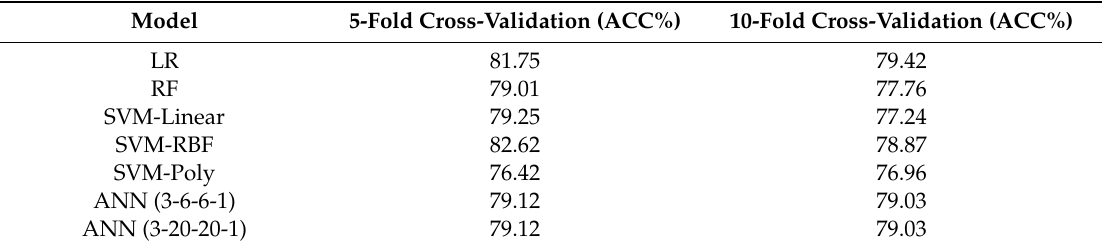
Table 17. A Comparison of the accuracies achieved by the ML models and the baseline model (LR) after performing 5- and 10-Fold Cross-Validation without running grid search